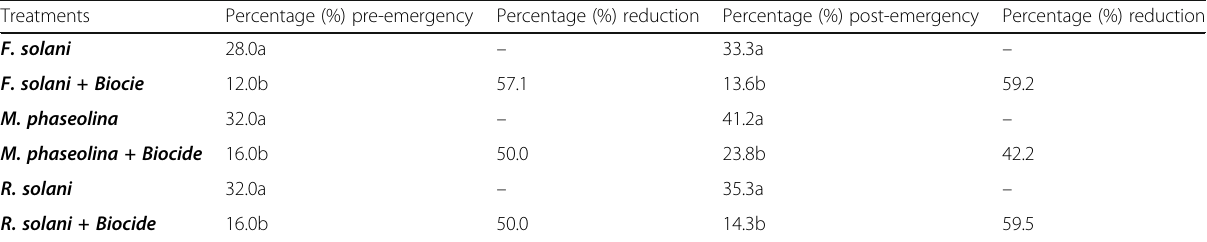
Table 3 Effect of bean seed application with biocide on pre- and post-emergence damping off caused by F. solani , M. phaseolina , and R. solani